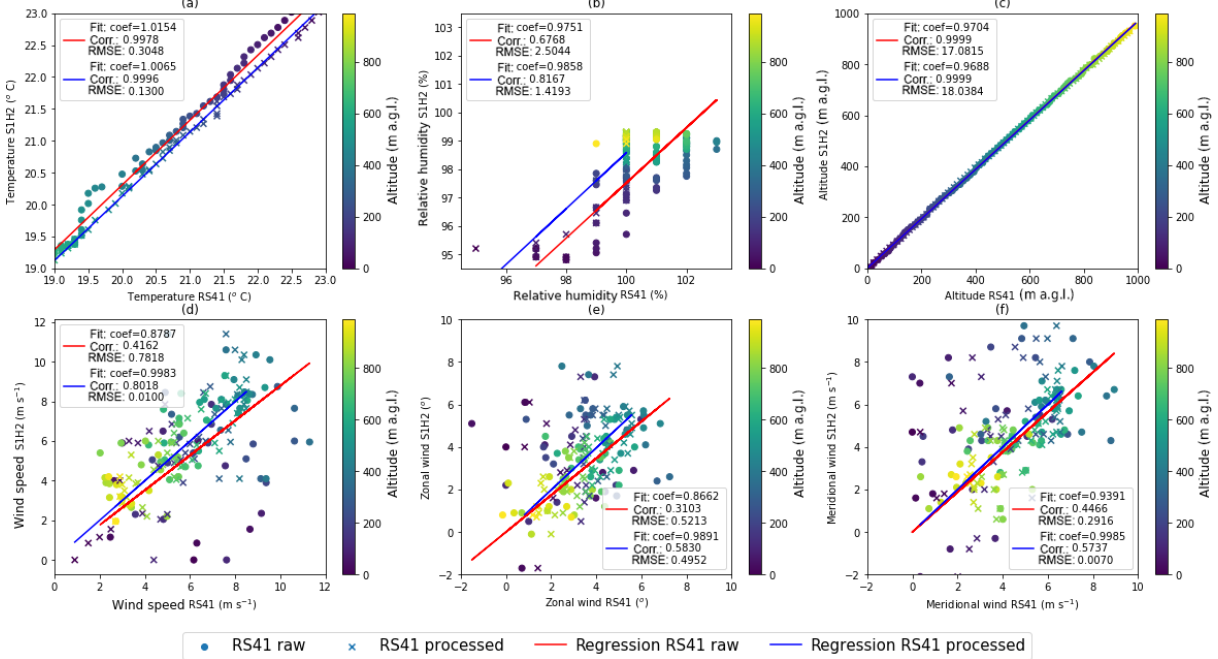
Figure 6. Comparison of temperature (a) , relative humidity (b) , altitude (c) , wind speed (d) , zonal winds (e) , and meridional winds (f) recorded by the Windsond S1H2 and the Vaisala RS41-SG before and after processing during the flight of 28 June 2016, 05:44UTC in Kumasi. The colours are based on the Vaisala RS41-SG-measured altitude with the maximum altitude set to